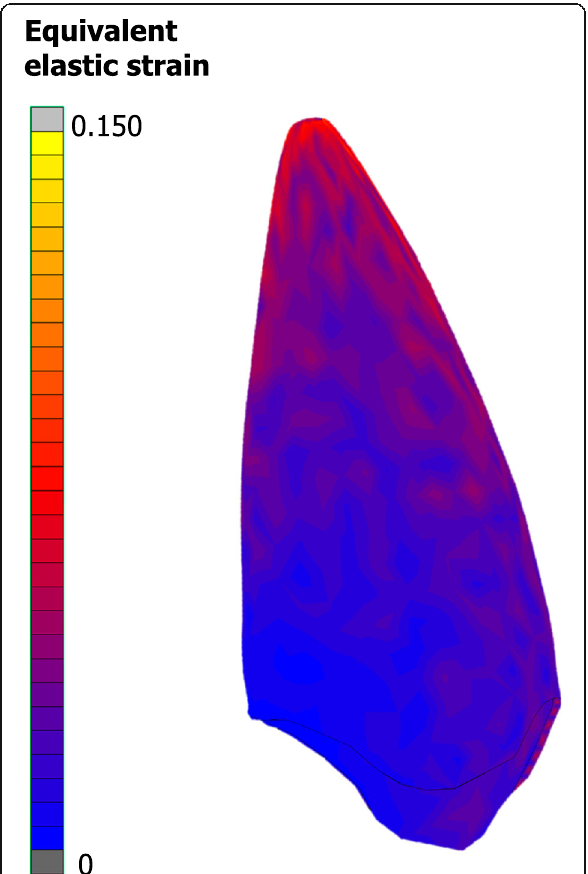
Fig. 3 Example showing the distribution of calculated displacements in the labiolingual direction. Displacements are magnified optically by 30 at the last increment (tooth with contour bands) to differentiate it from the initial model (tooth with green mesh)